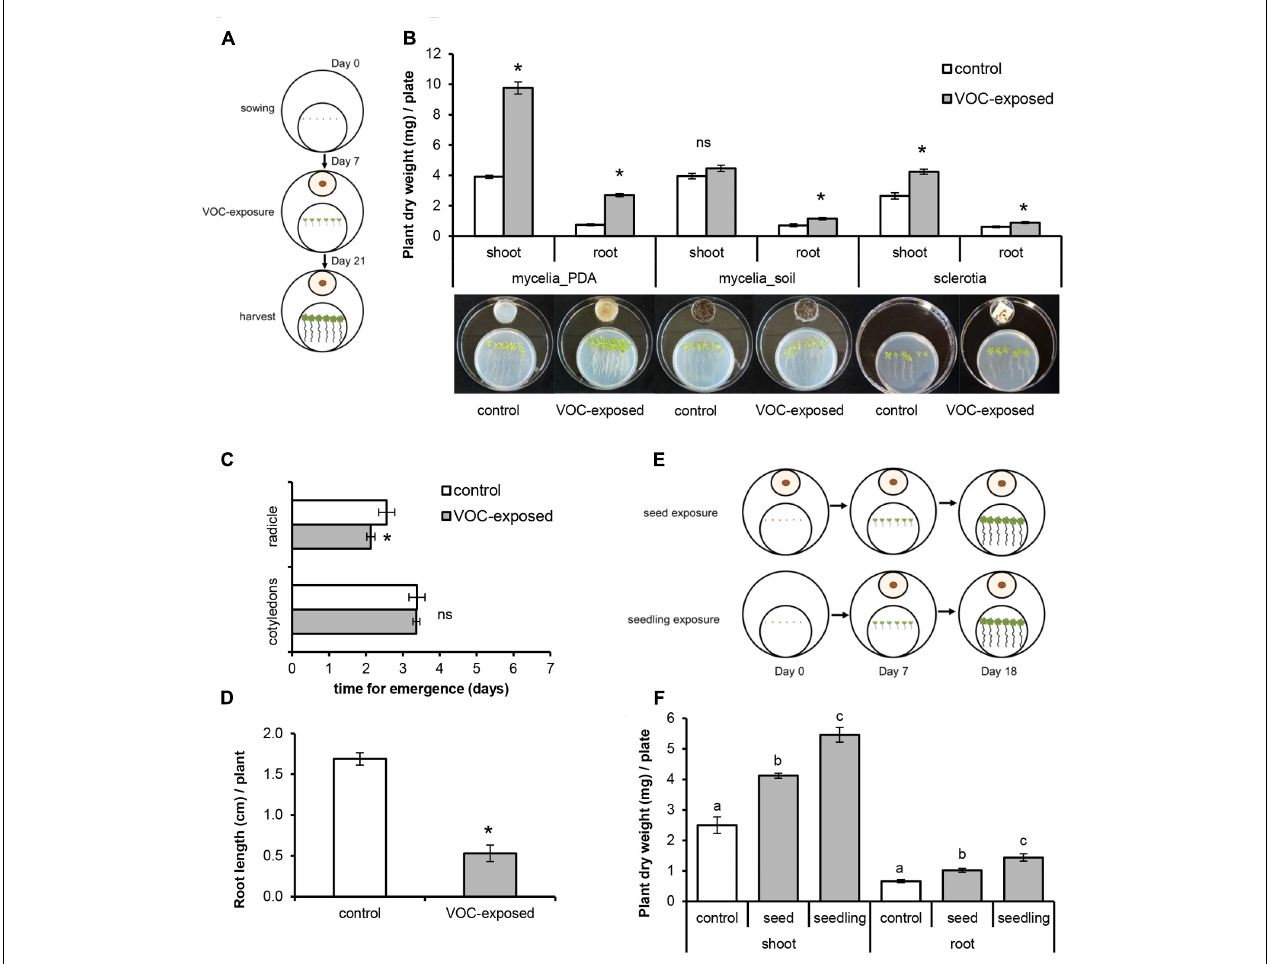
FIGURE 1 | Effects of volatile organic compounds (VOCs) produced by Rhizoctonia solani on growth and development of Arabidopsis thaliana . Plants exposed to the fungal VOCs are referred as ‘VOC-exposed’ whereas plants exposed to agar medium or soil-sand mixture are referred as ‘control.’ Each biological replicate consists of one Petri dish with six seedlings each. Asterisks indicate statistically significant differences based on pairwise comparisons between VOC-exposed and control plants (Student’s t -test or Mann–Whitney U test, P < 0.05). Non-significant differences are displayed as ‘ns’. (A) Schematic representation of the experimental set-up to expose seedlings to fungal VOCs. (B) Biomass (mean ± SE, n = 5–8) of shoots and roots exposed to VOCs produced by fungal mycelium grown on 1/5 th Potato Dextrose Agar medium (mycelia_PDA) and on soil-sand mixture (soil_mycelia), and to VOCs produced by fungal sclerotia. (C) Time of emergence (mean ± SE, n = 8) of radicle and cotyledons of VOC-exposed and control plants. (D) Primary root length of VOC-exposed and control plants at 7 days after exposure of A. thaliana seeds to fungal VOCs. (E) Schematic representation of the experimental set-up to expose seeds and seedlings to fungal VOCs. (F) Biomass (mean ± SE, n = 5) of shoots and roots of VOC-exposed and control plants at the seed and at the seedling (7 days old) stages. Different letters indicate statistical differences between treatments (One-way ANOVA, Tukey post hoc test, P <